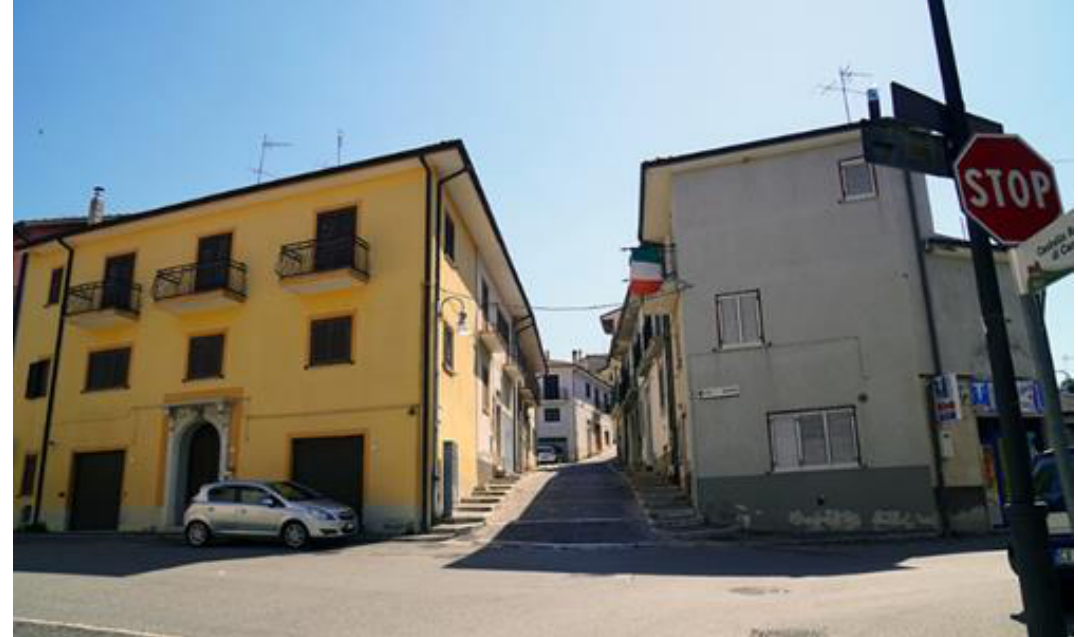
Figure 79. Torella dei Lombardi: details of the new buildings (photos by [35,36]).